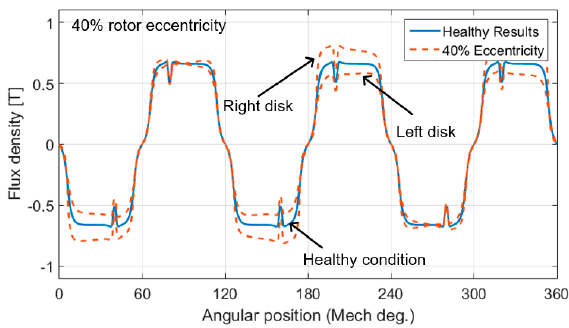
Figure 15. Total flux density comparison at the air gap under no-load condition.